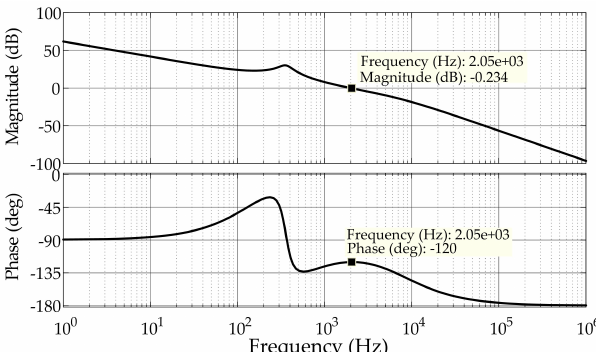
Figure 6. Bode plots for the open-loop transfer function with the ISLC with GCF = 2 kHz.